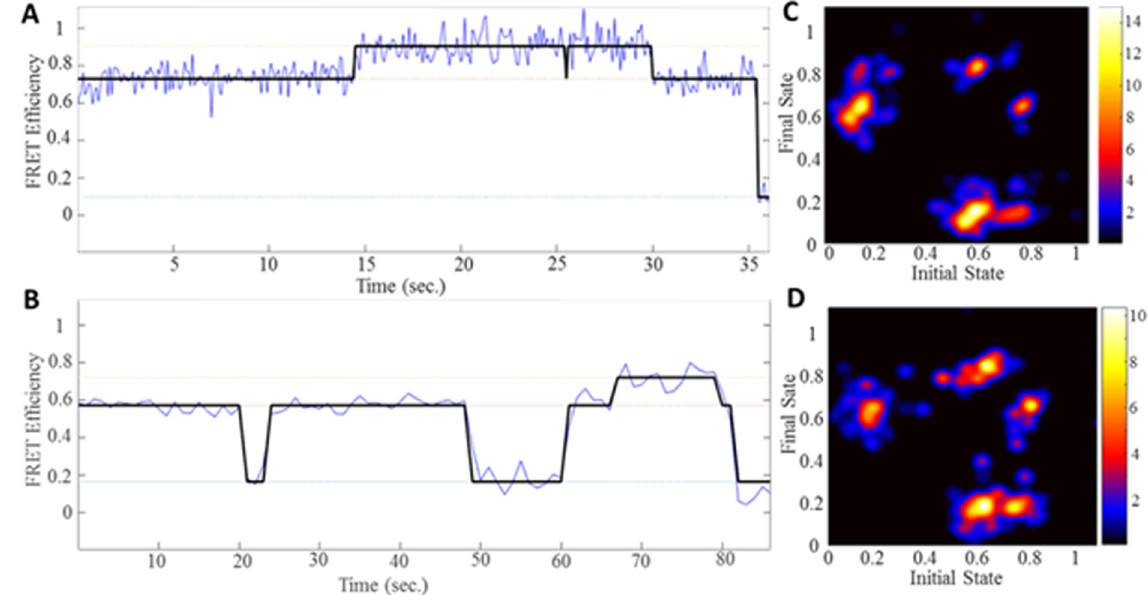
Fig 4. Human WT and G249D TRIM5 α exhibits similar conformational dynamics by Hidden Markov Model analysis. Idealized FRET traces were obtained by fitting each trace to a three state Markov Model (in black) for WT (A) and G249D (B) CCL2 dimer (in blue). Transition density plots were generated from the modelled FRET trajectories for WT (C) and G249D (D) CCL2 dimer (68 and 52 traces with 240 and 185 transitions were used for generation of TDP plots for WT and G249D respectively).